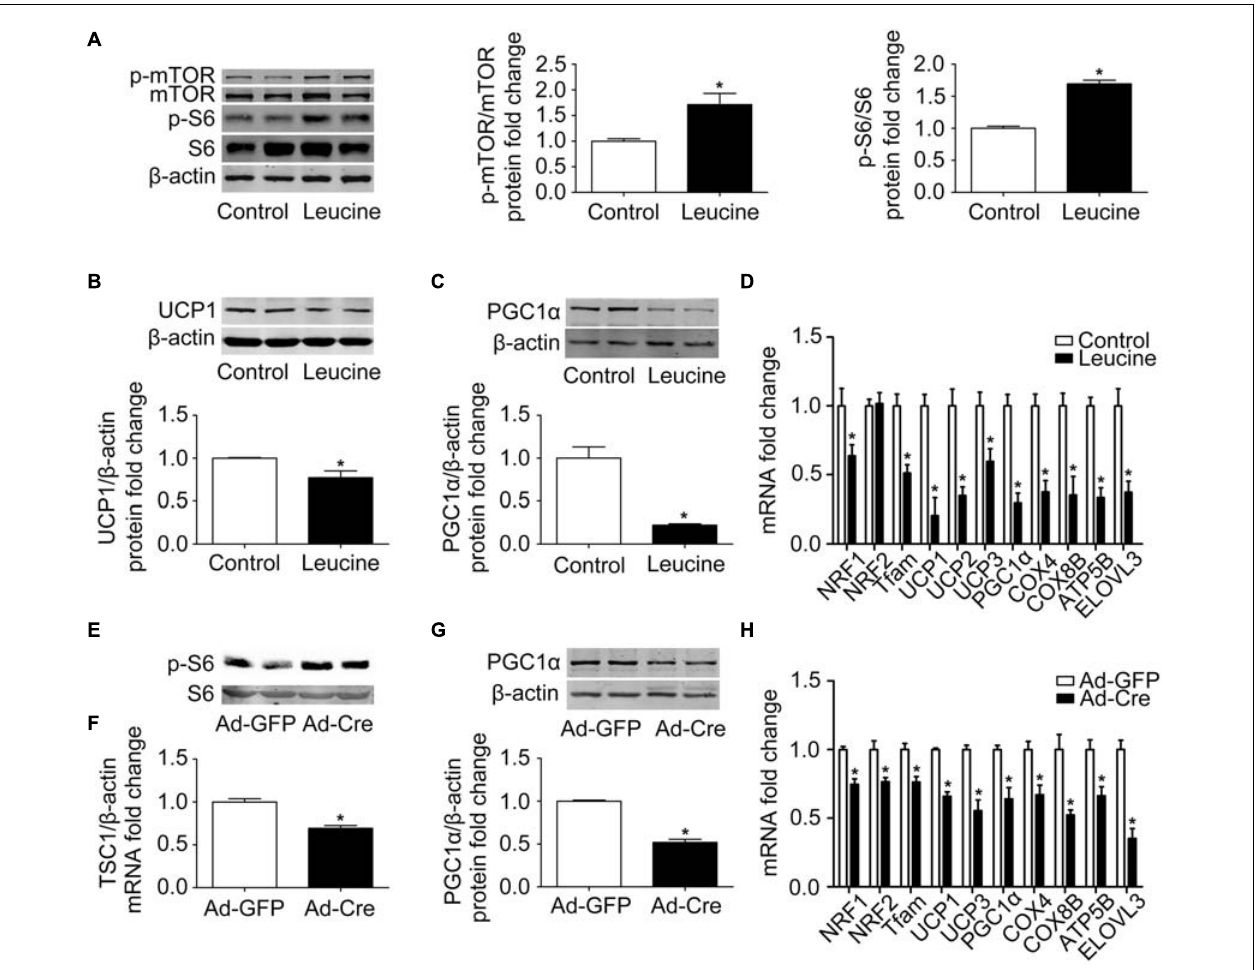
FIGURE 1 | Activation of mTOR inhibits mitochondrial biogenesis of brown adipocytes. (A–C) Primary brown adipocytes were isolated from neonatal C57BL/6J mice and cultured for differentiation. Proteins were extracted after 6 days of differentiation. Western blotting of p-mTOR, p-S6, UCP1, and PGC1 α were performed with β -actin used as a loading control. Relative protein signal intensity was quantified and expressed as means ± SD. (D) Total RNAs were extracted after 6 days of differentiation. Real-time PCR was performed to evaluate the expression of mitochondrial biogenesis marker genes with β -actin used as a loading control and results expressed as means ± SD. *Denotes P < 0.05 relative to control. (E,F) Tsc1 loxp / loxp brown adipocytes were treated with Cre adenoviruses for 48 h and controls with GFP adenoviruses. RNAs and protein were extracted as described in the methods section. Real-time PCR was performed to evaluate the expression of TSC1. Levels of mRNA expression were normalized to β -actin and expressed as means ± SD. Western blotting of p-S6 and total S6 was performed. (G) Representative results of western blot for PGC1 α . β -Actin was used as the loading control. Relative protein signal intensity was quantified and expressed as means ± SD. (H) Real-time PCR was performed to evaluate the expression of genes related to mitochondrial biogenesis. Levels of mRNA expression were normalized to β -actin and expressed as means ± SD. * P < 0.05 vs.